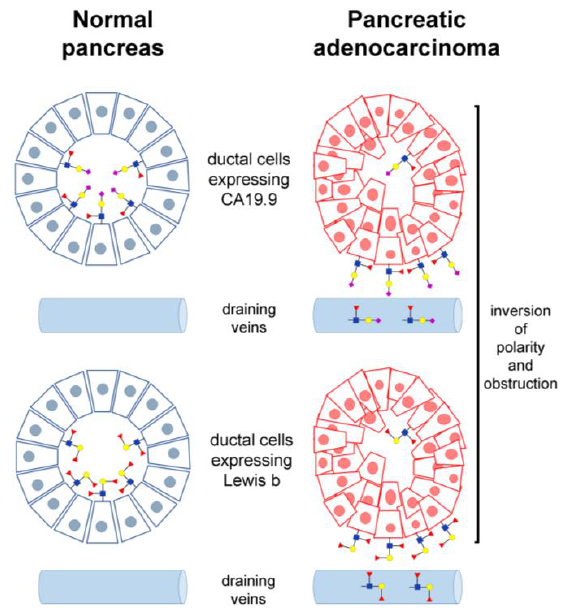
Figure 2. Proposed model of the elevation of circulating CA19.9 in pancreatic cancer patients. The inversion of polarity occurring in malignant ductal cells [125] together with the obstruction of the